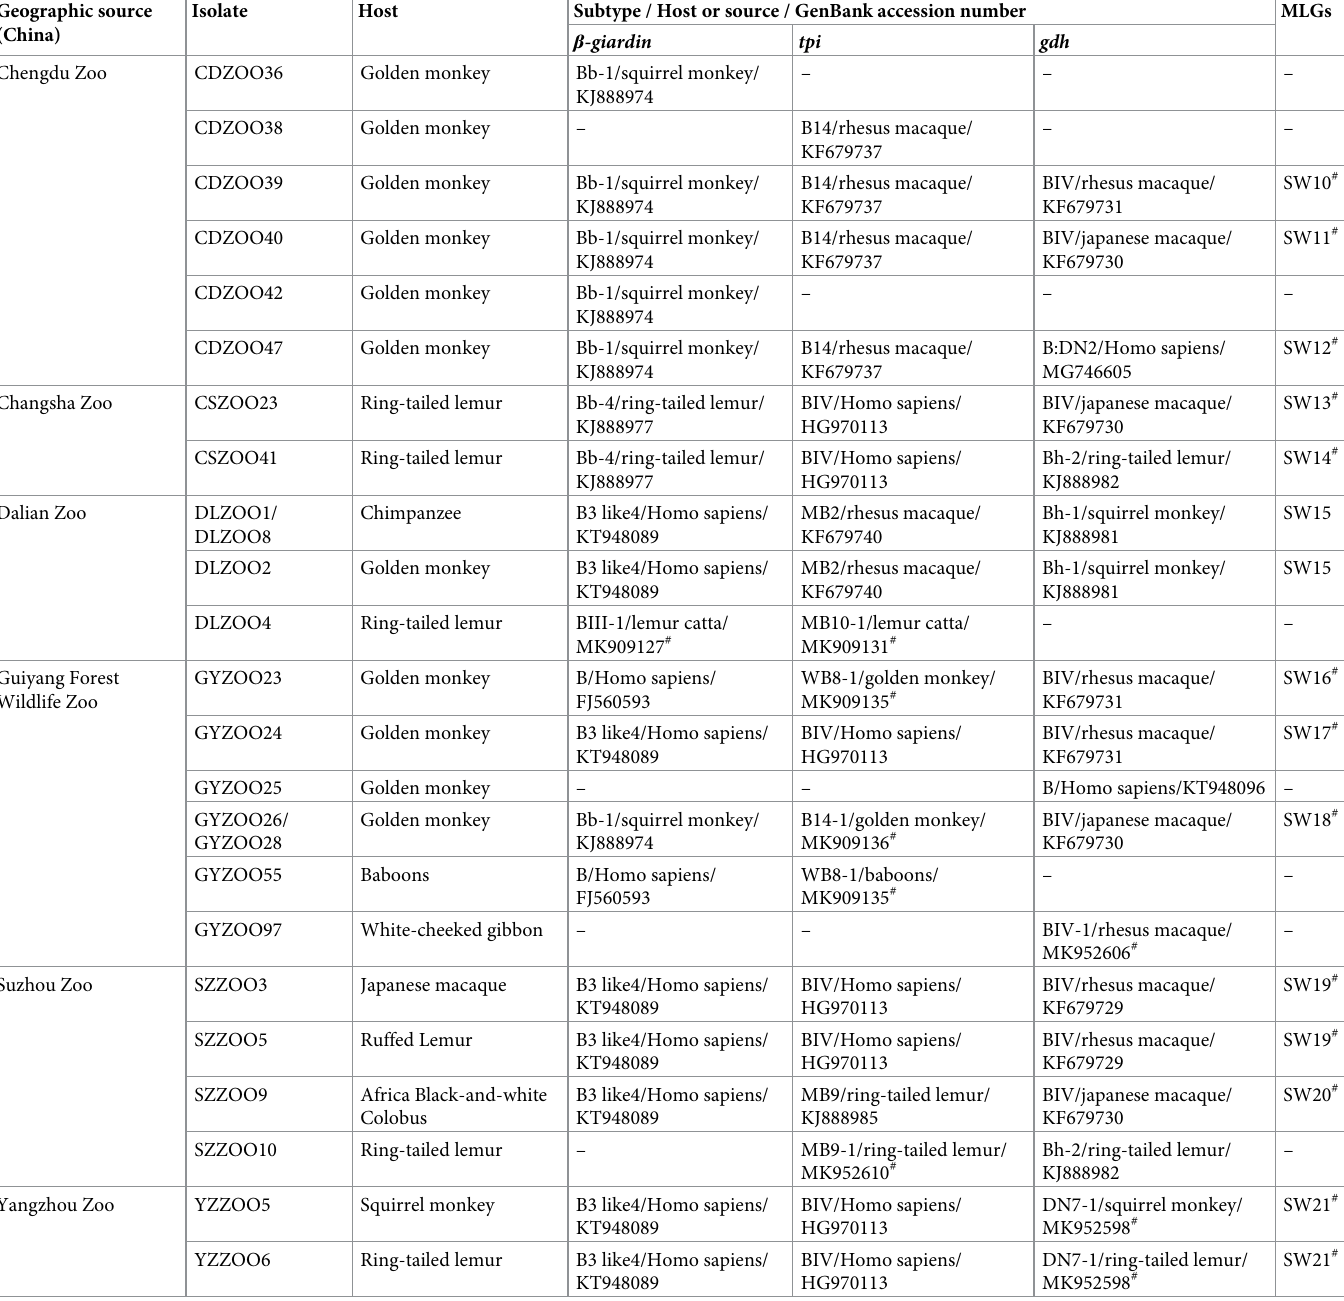
Table 3. Multi-locus sequences of bg , tpi and gdh genes for 25 G . duodenalis positive faecal samples. Geographic source